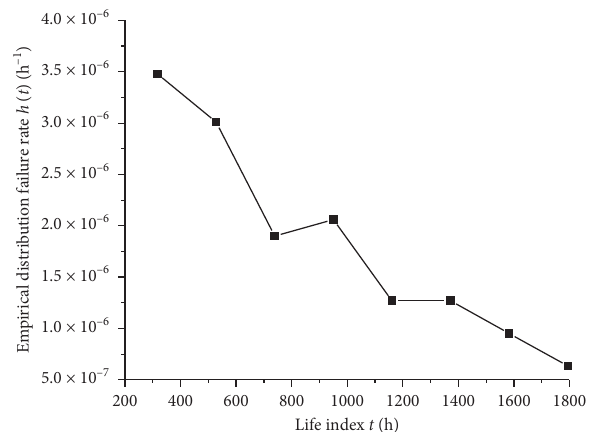
Figure 5: Failure rate of empirical